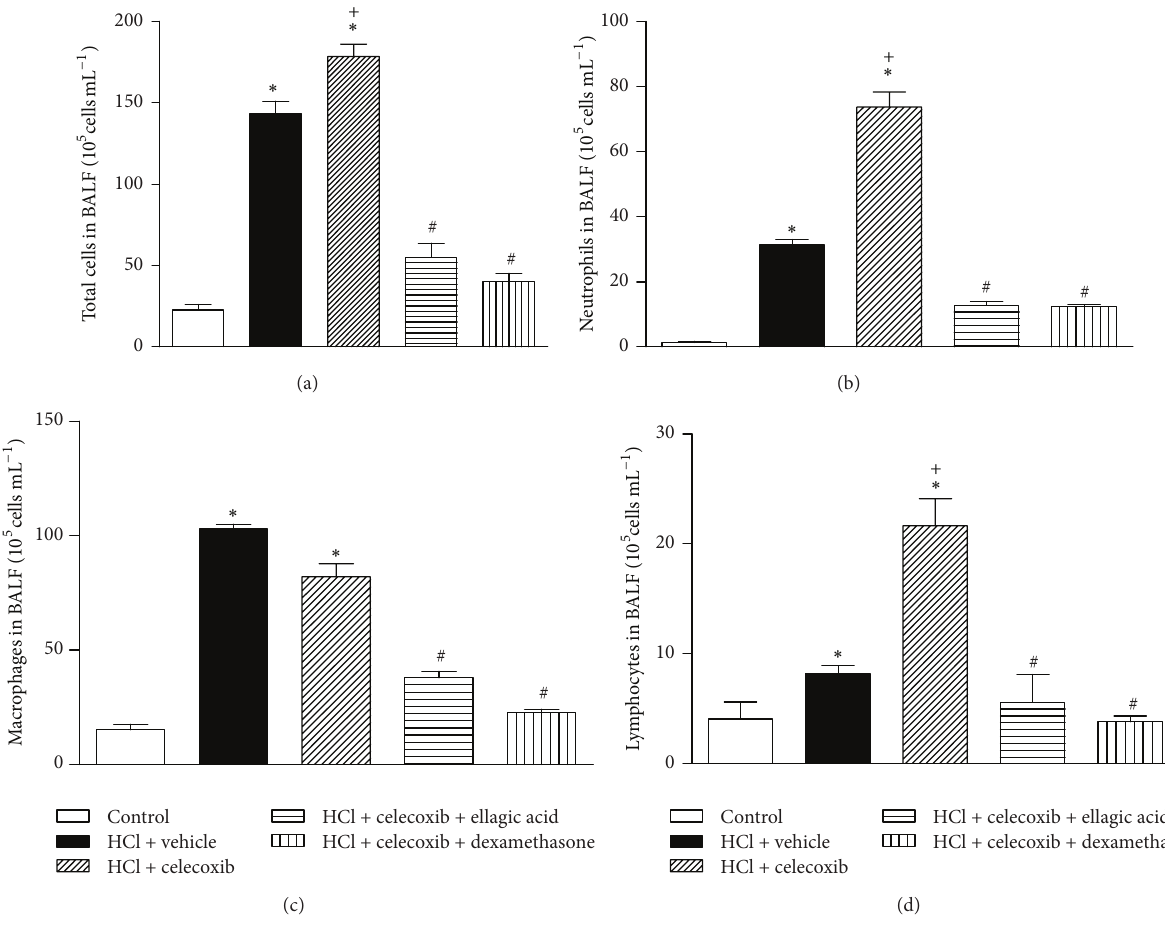
Figure 6: Ellagic acid (therapeutic treatment) dampens the exacerbation of inflammation induced by COX-2 inhibition in experimental model of acid-induced acute lung injury. Mice received ellagic acid (10mg/kg, p.o.), dexamethasone (1mg/kg, s.c.), or vehicle (water, p.o.) after (2, 24, and/or 47 h) the acid intratracheal instillation into the left lung. (a) Total leukocytes, (b) neutrophils, (c) macrophages, and (d) lymphocytes were evaluated in the BALF at 48 h after the acid instillation. Results represent the mean ± SEM of two or more independent experiments with three mice per group per experiment. ∗ 𝑃 < 0.05 compared with control group; + 𝑃 < 0.05 compared with HCl + vehicle group; # 𝑃 < 0.05 compared with HCl + celecoxib